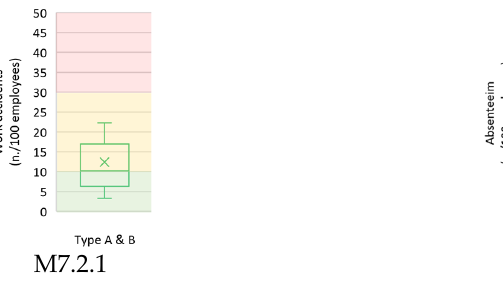
Figure 10. Results of the validation applied to the wastewater utilities: objective 6.